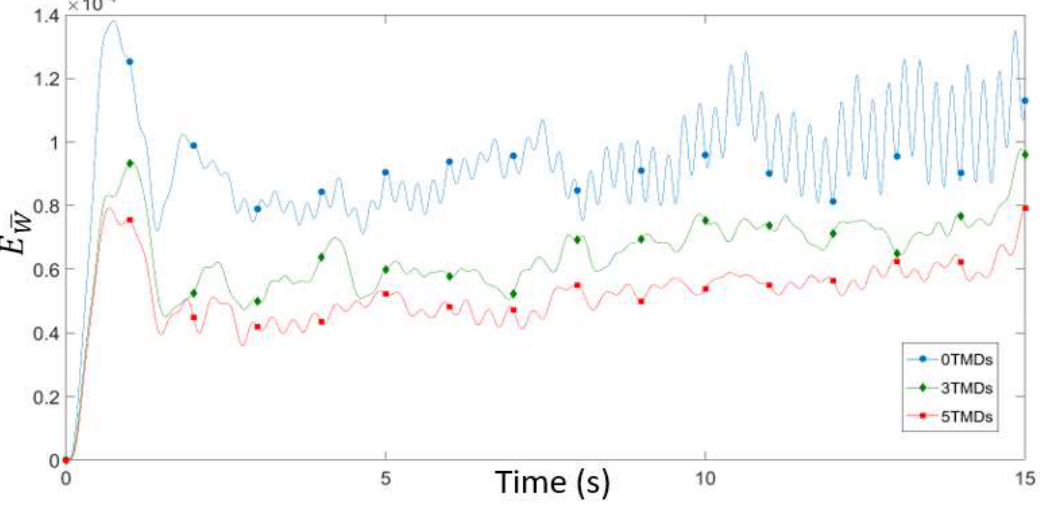
Figure 3. Mean Figure 3. Mean displacement. Figure 3. Mean displacement.